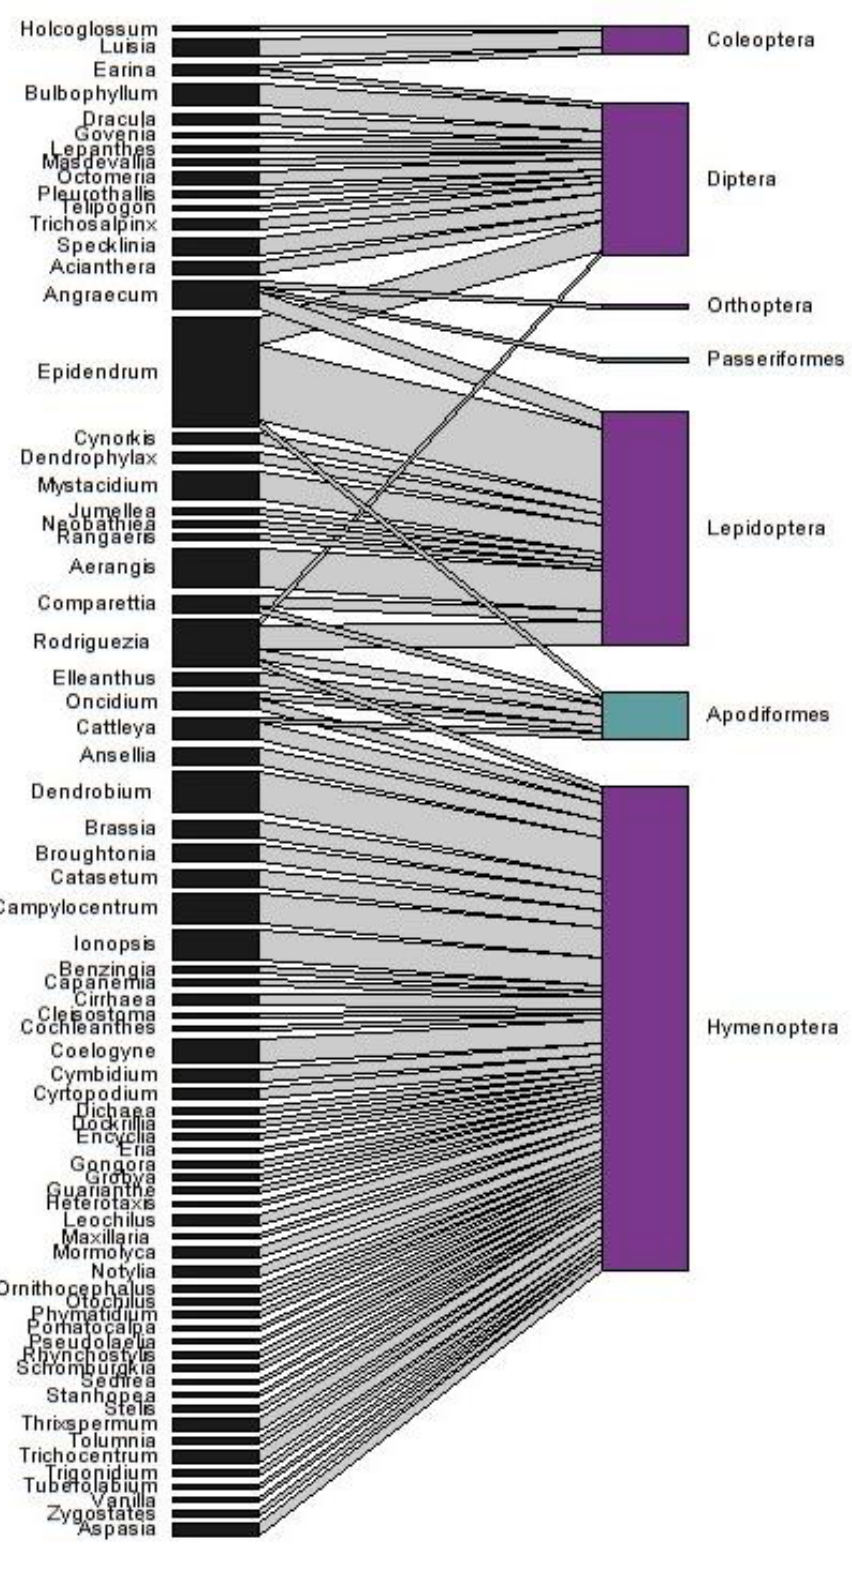
Figure 3. Bipartite interaction web of epiphytic orchid genera (left) and the taxa that have been observed as pollinators (right). Each bar represents at least one instance of a pollinator interaction between the two taxa. The thicker the connecting bars are between the two groups, the more documented instances of pollination by a species in that genus have occurred. The order of the taxa was arranged by R to show the fewest number of overlapping bars. Taxa with purple bars represent insects, while taxa with blue bars represent